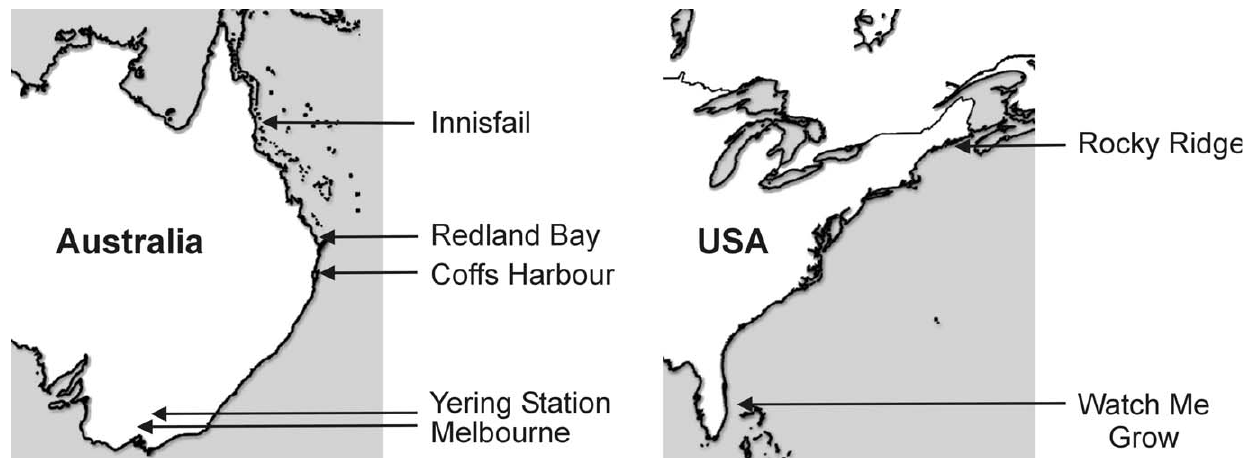
Figure 1. Geographical origin of the different D.melanogaster populations analyzed in this study.